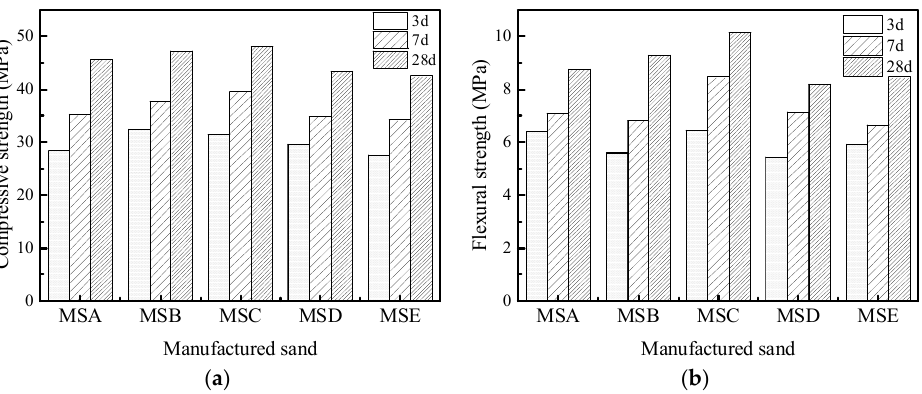
Figure 18. Mechanical properties of concrete under MF1 mix proportion: ( a ) compressive strength ( b ) and flexural strength.